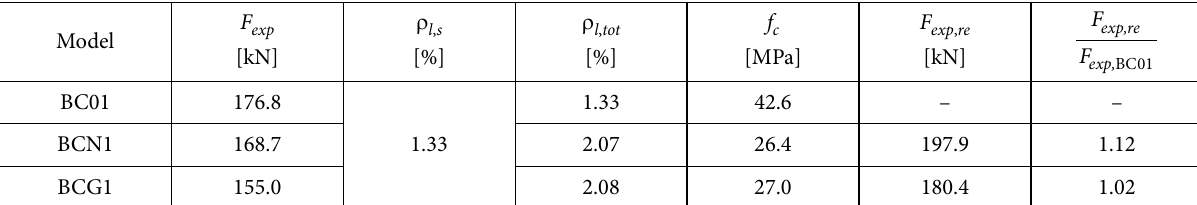
Table 2. The characteristics of the models considered in the research by Moreno et al. (2015)